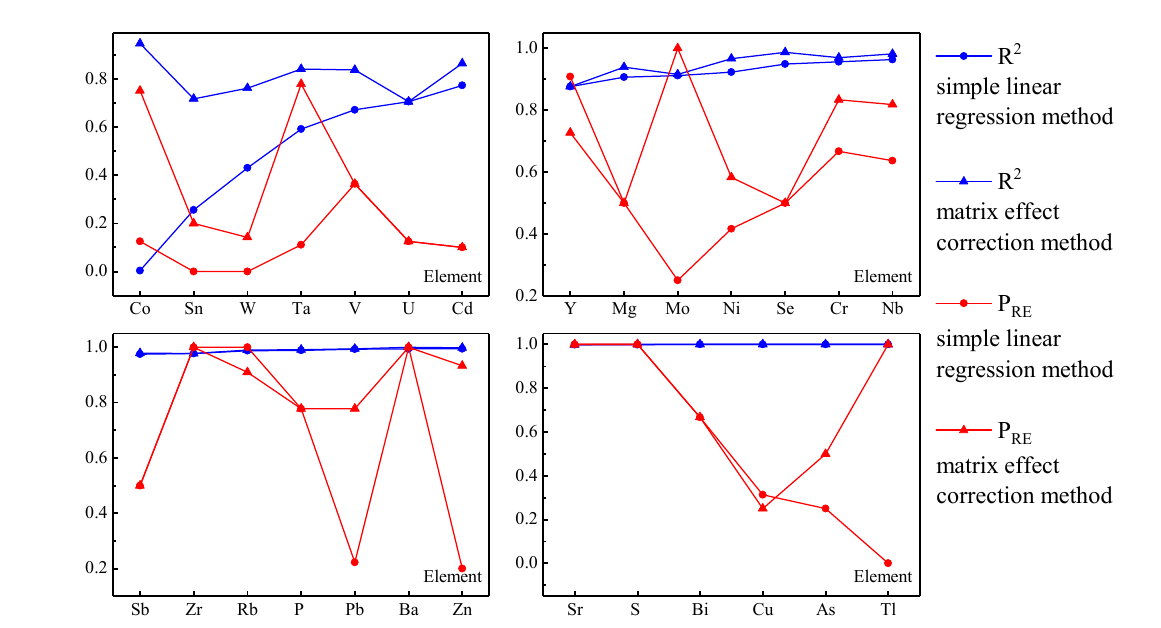
Figure 3. The R 2 and P RE values for the correction results of the new and SLR methods.